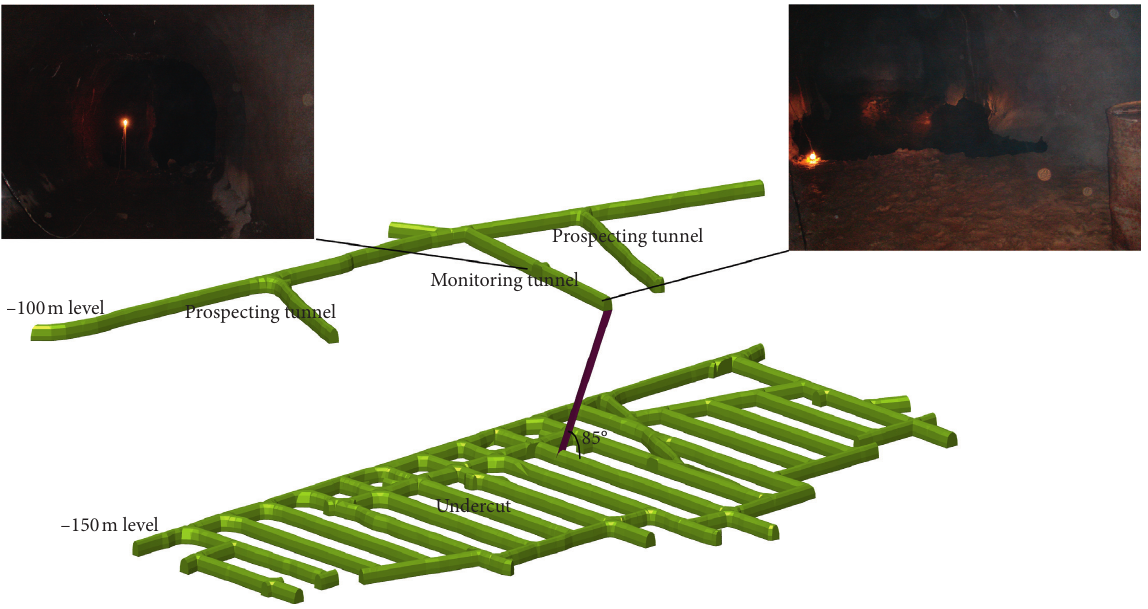
Figure 9: Monitoring of caving